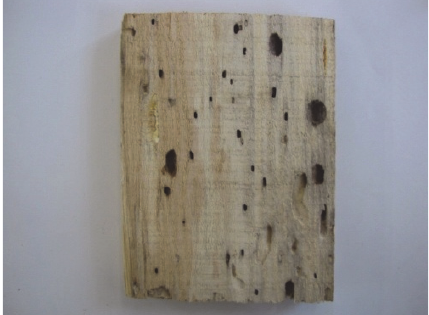
Figure 4: The segmented defects displayed with different colors.